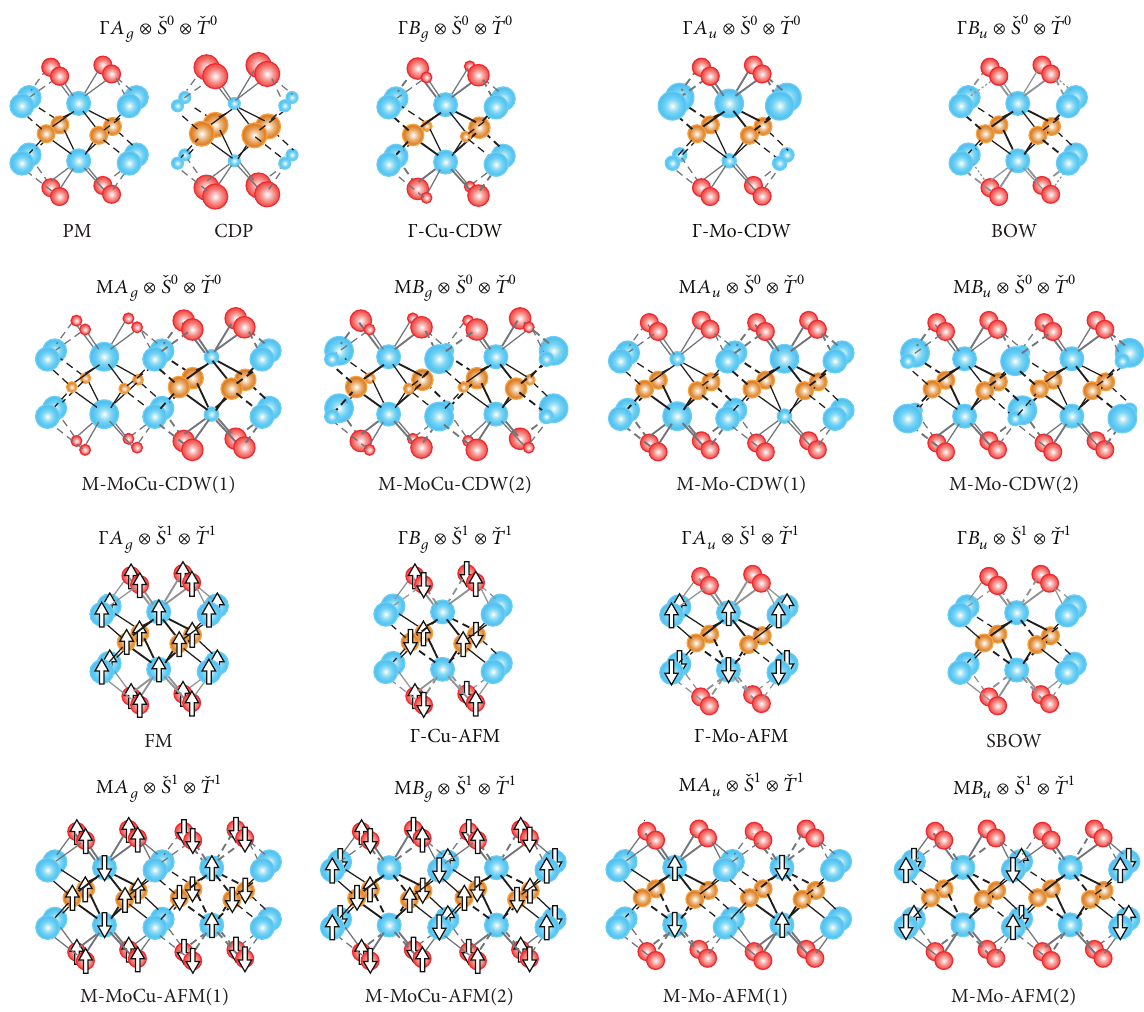
̆𝐷(Γ)⊗ ̆𝑆 0 ⊗ ̆𝑇 0 ̆𝐷( ̆𝑆 0 ⊗ ̆𝑇 0 ̆𝐷(Γ)⊗ ̆𝑆 1 ⊗ ̆𝑇 1 ̆𝐷( ̆𝑆 1 ⊗ ̆𝑇 1 Figure2:Possiblenonmagnetic[ Γ andM M )⊗ ]andmagnetic[ Γ andM M )⊗ ]states,wherevaried circles and arrows represent oscillating electron and spin densities, respectively, and varied segments in the nonmagnetic and magnetic states describe oscillating bond orders and spin bond orders, respectively. They consist of paramagnetism (PM) and charge disproportionation (CDP) of full symmetry, charge density waves (CDWs) within the molybdenum and/or copper sublattices, a bond order wave (BOW), ferromagnetism (FM), antiferromagnetism (AFM) within the molybdenum and/or copper sublattices, and a spin bond order wave